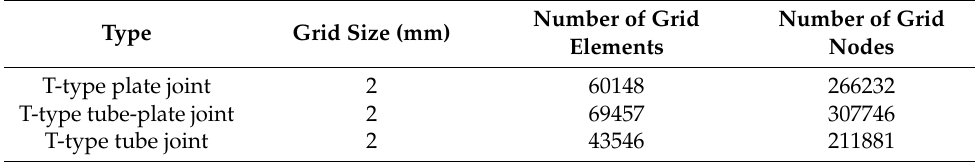
Table 8. Mesh information of each joint.